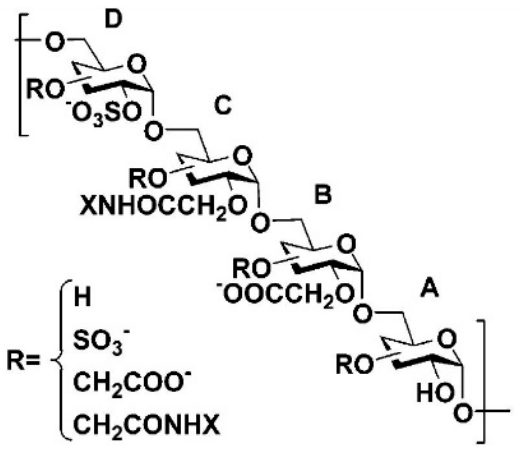
Scheme 1. General structure of heparan sulfate mimetic polymers. Four differently substituted units (A, B, C and D) can be present in HSm polymers (adapted from [32]).